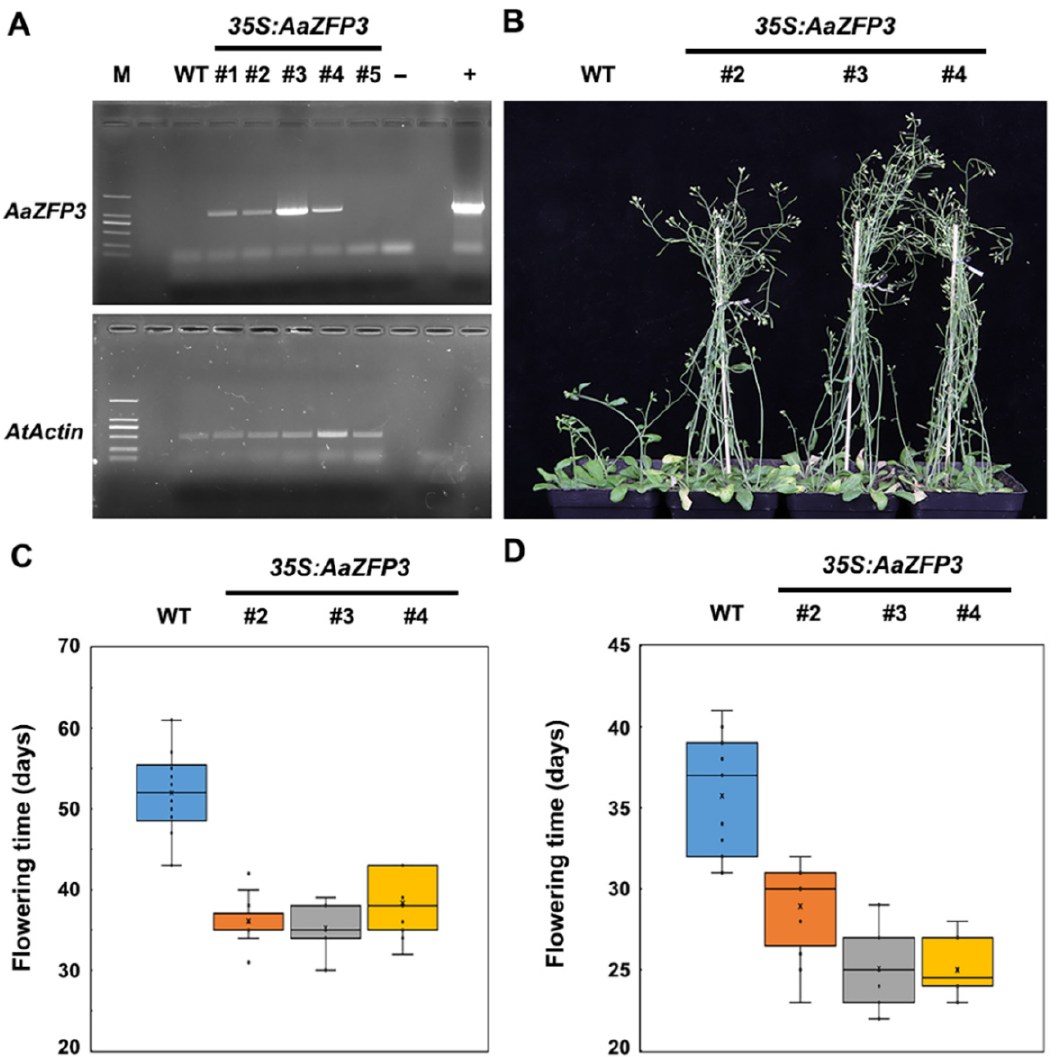
Figure 3. Flowering time of soil-grown wild-type (WT) plants and transgenic Arabidopsis plants overexpressing AaZFP3 . ( A ) Reverse transcript-PCR analysis of AaZFP3 expression in WT and transgenic Arabidopsis lines (#1~#5). AtActin1 (At2g37620) was used as an internal control. M, marker; +, positive control; − , negative control (H 2 O). ( B ) Flowering phenotype of WT and transgenic Arabidopsis plants (#2, #3, #4) grown in soil under a 12 light/12 h dark photoperiod at 22 °C. ( C , D ) Box plots of flowering time for WT and transgenic Arabidopsis plants (#2, #3, #4) under a 12 light/12 h dark ( C ) and 16 light/8 h dark ( D ) photoperiod at 22 °C. The interquartile range box represents the middle 50% of the data. Whiskers extend 1.5 times the interquartile range and the center line marks the median. n ≥ 15 plants per line.